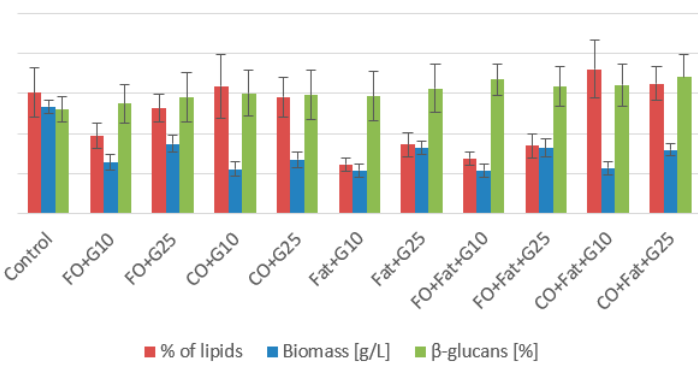
Figure 6. Phase I: Biomass, lipid, and β -glucan production of Rhodotorula toruloides cultivated on a combination of waste lipids and glycerol.